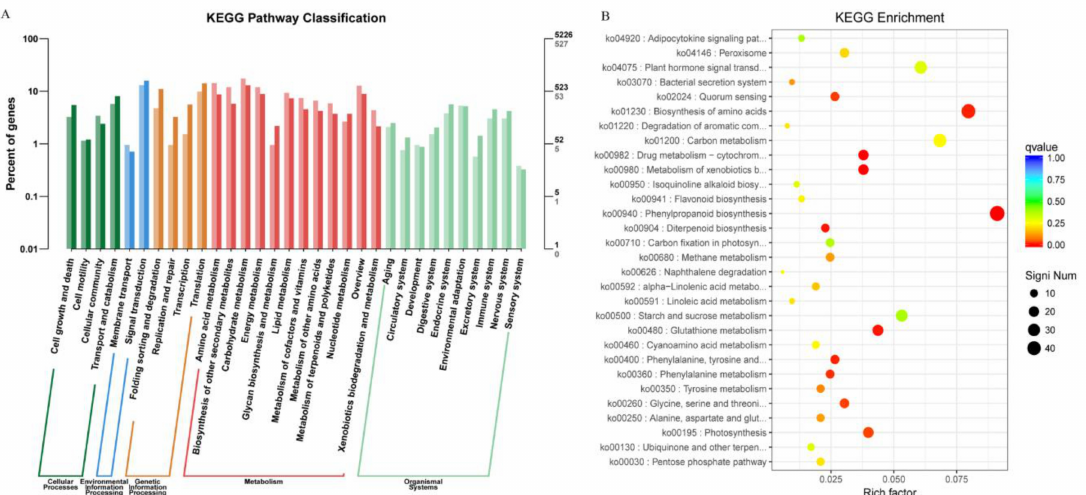
Figure 5. KEGG (Kyoto encyclopedia of genes and genomes) analyses of DEGs between bml and WT at early-tillering stage by barplot and scatter diagram. ( A ). KEGG analysis of DEGs through barplot. The horizontal axis is the functional classification, and the vertical axis is the number of genes in the classification (right) and the percentage of the total number of genes on the annotation (left). Different colors represent different classifications: light colors on the histogram and axis represent differential genes, and dark colors represent all genes. ( B ). Scatter plot of significant enrichment function. The vertical axis represents functional annotation information, and the horizontal axis represents the function of the Rich Factor (the number of differential genes annotated to the function divided by the number of genes annotated to the function). The size of the Q value is represented by the color of the dot; the smaller the Q value, the closer the color is to red, and the more the differential genes contained under each function are represented by the size of the dots. Only the top 30 GOs with the highest levels of enrichment were